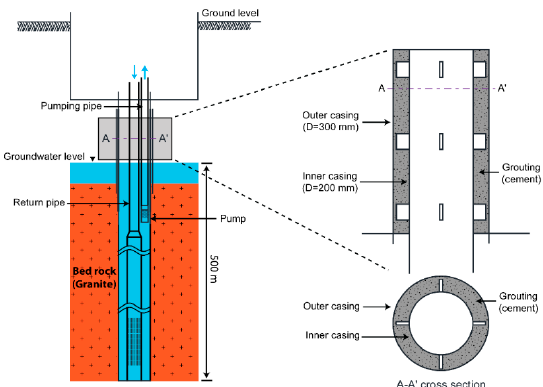
Figure 1. Schematic diagram of the groundwater heat pump (GWHP) well (adapted from Kim et al. [6]).